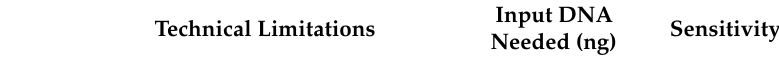
Input DNA Sensitivity Needed (ng)